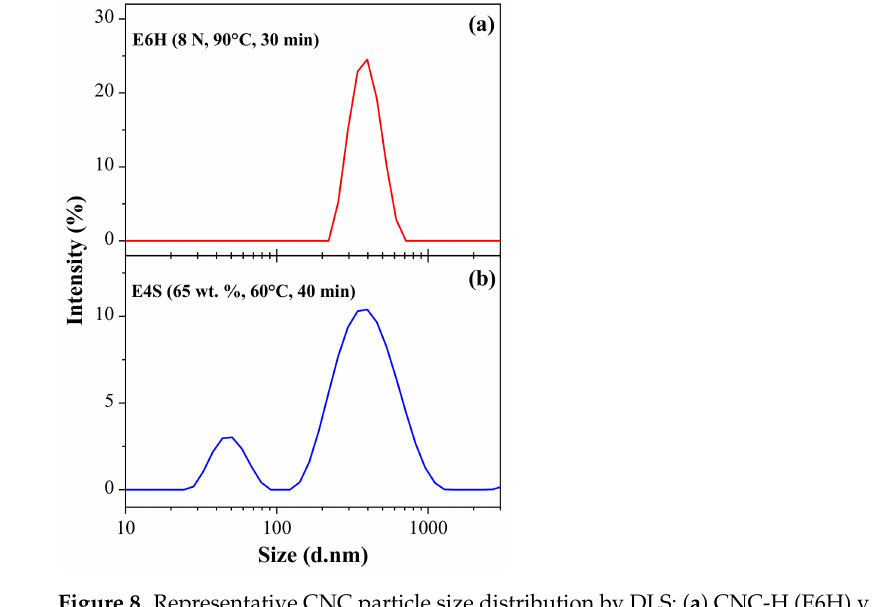
Figure 8. Representative CNC particle size distribution by DLS: ( a ) CNC-H (E6H) y ( b ) CNC-S